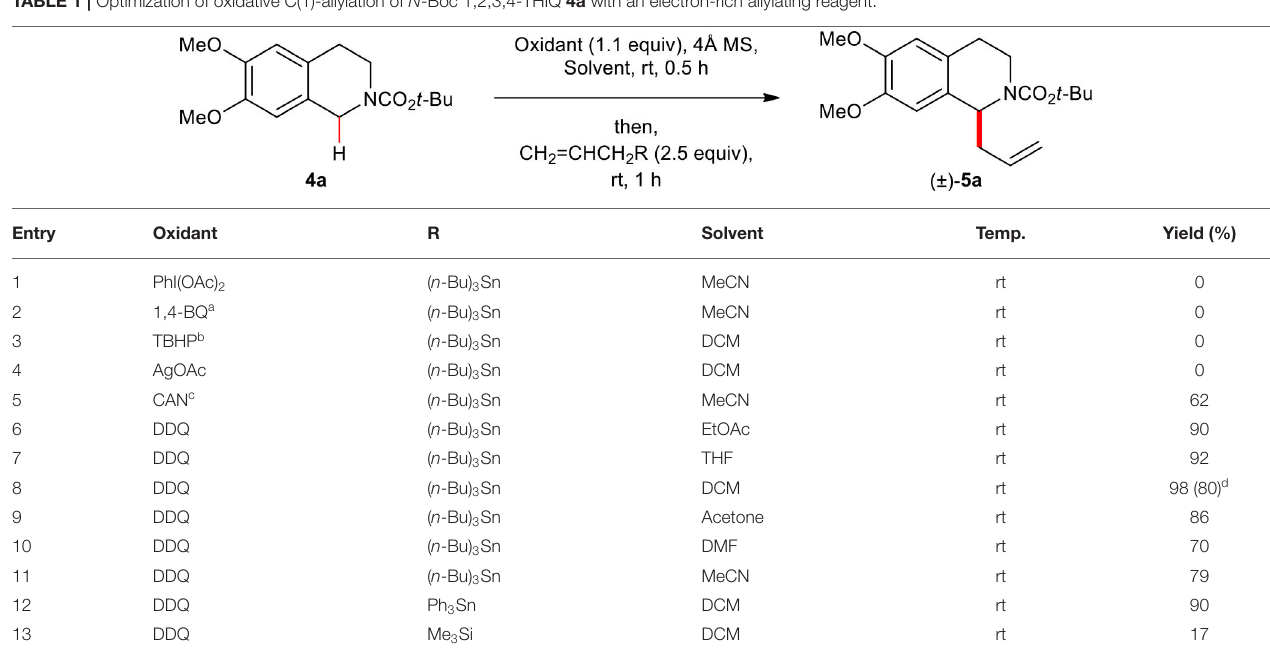
TABLE 1 | Optimization of oxidative C(1)-allylation of N -Boc 1,2,3,4-THIQ 4a with an electron-rich allylating